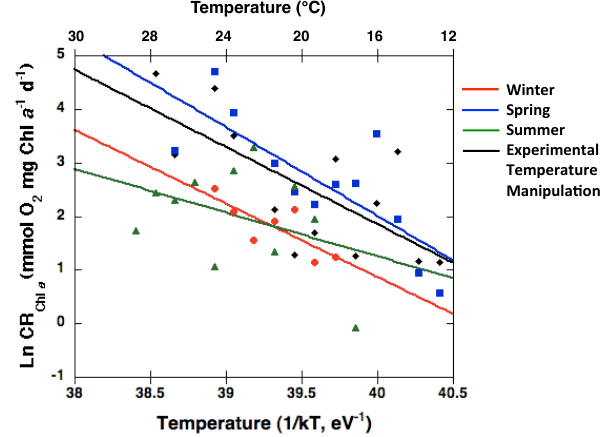
Figure 5. Arrhenius plot showing the relationship between aver- age Chl a -specific respiration rate within 1 ◦ C bins and the inverted water temperature (1 /kT , where k is the Boltzmann’s constant, 8.617 × 10 − 5 eVk − 1 , and T is the water temperature in ◦ K) for ex- perimental temperature manipulations conducted during the spring cruise as well as Arrhenius plots for winter, spring and summer cruises for comparison.